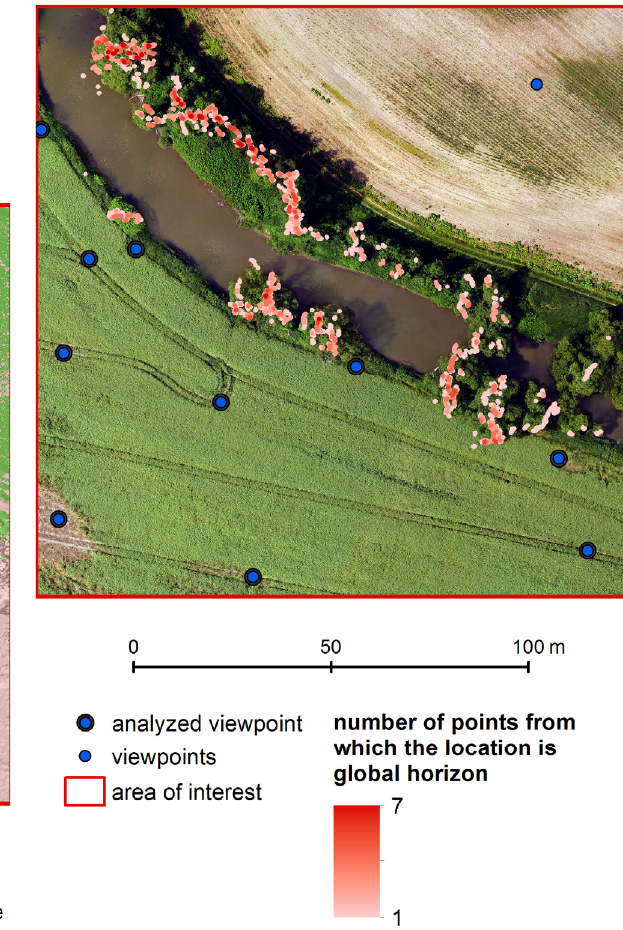
Figure 4. Multiple global horizon viewshed for the points in southern part of the area of